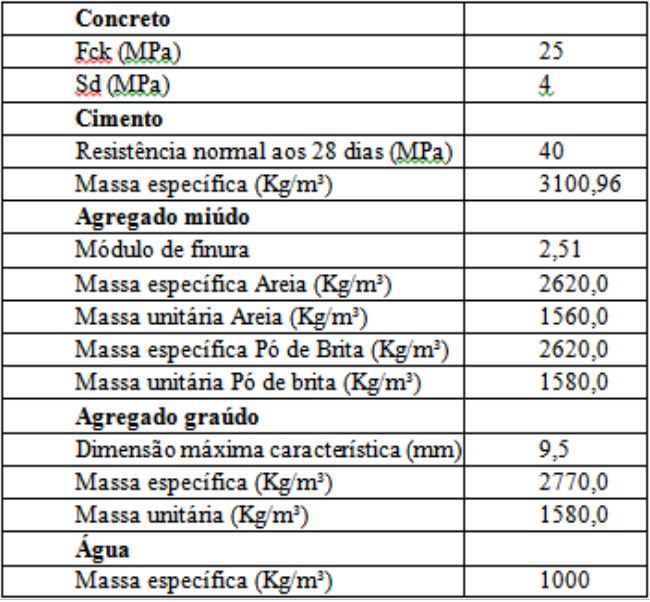
Tabela 1: Traço unitário do concreto convencional.